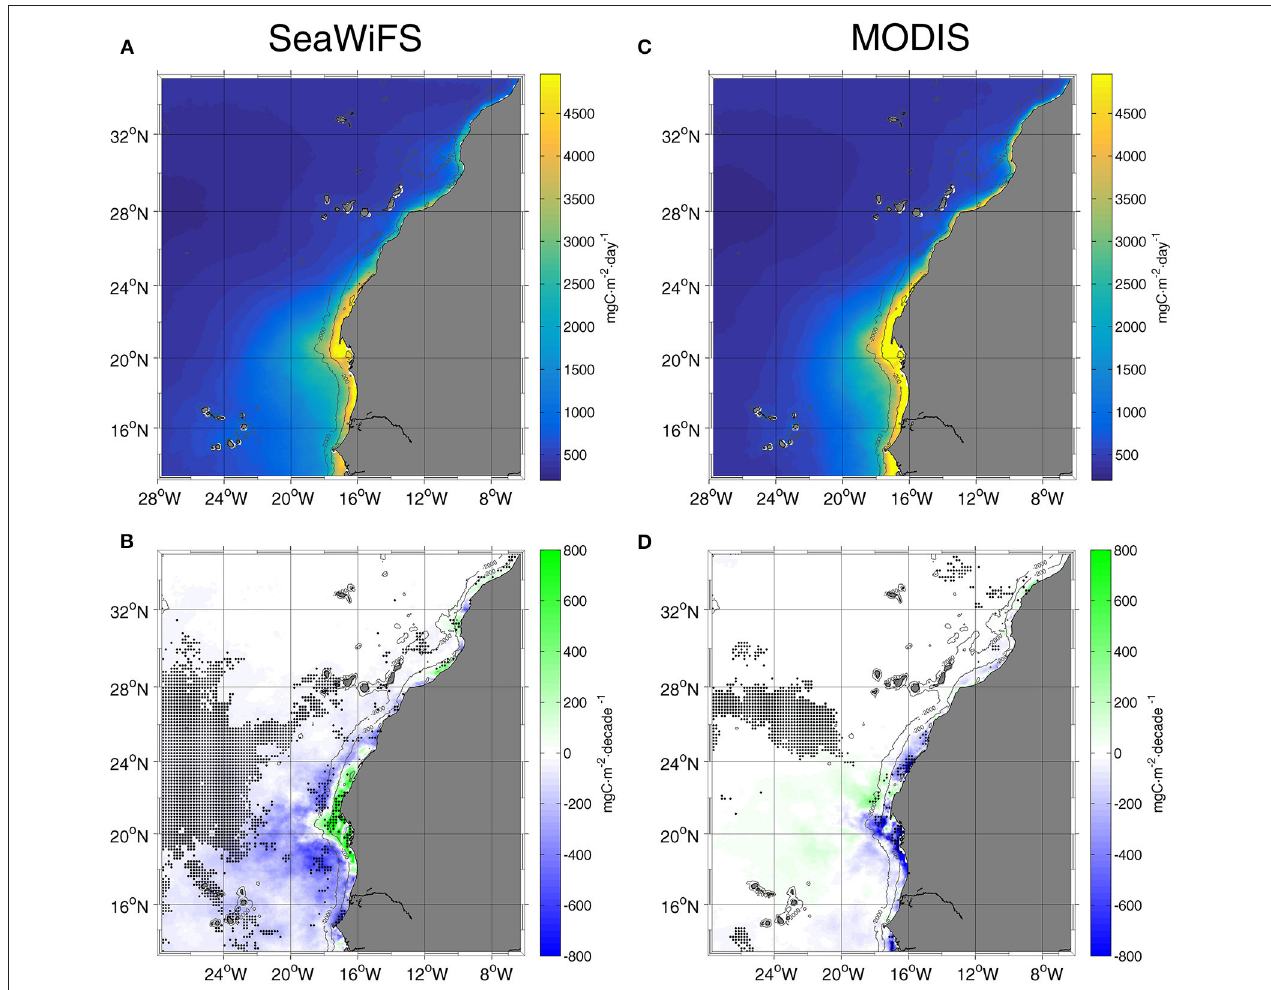
FIGURE 3 | Mean VGPM (A,C) and VGPM trend (B,D) maps for SeaWiFS (1998–2007, left column) and MODIS (2003–2015, right column) datasets. In (B,D) , black dots correspond to significant trends ( p < 0.05). 200 and 2,000m isobaths are represented by contour